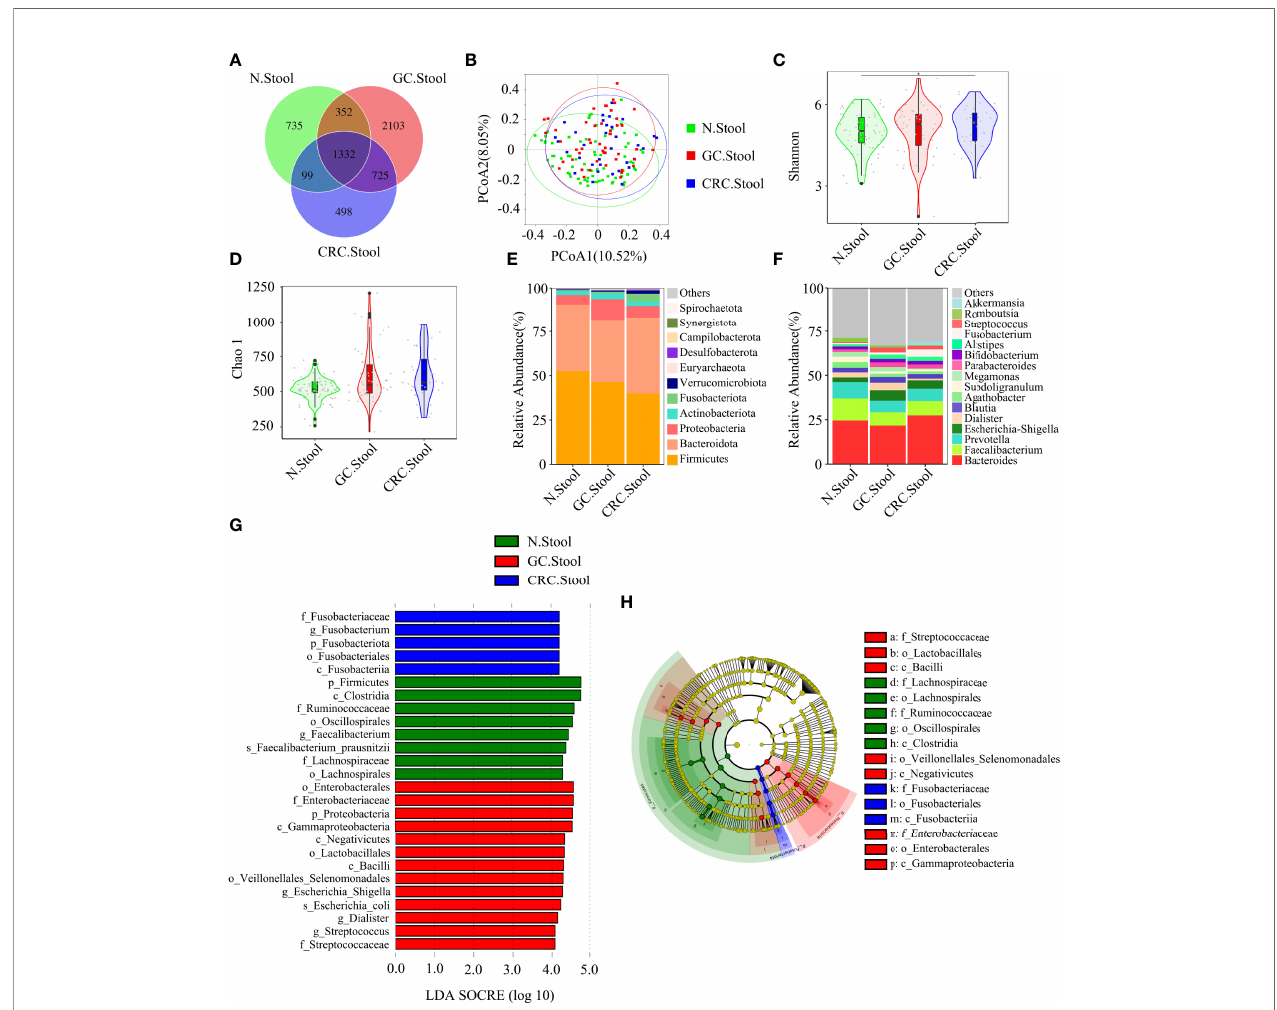
FIGURE 4 | There were differences in fecal microbial diversity among HC ( n = 70), GC ( n = 49), and CRC ( n = 33). (A) The Venn diagram displayed the overlaps among groups, showing a total of 5844 OTUs. (B) PCoA calculated b -diversity on a distance (dissimilarity) matrix of Bray – Curtis indexes. The Shannon index (C) and Chao1 index (D) were used to evaluate the fecal microbial diversity of patients with HC, GC, and CRC. Composition of fecal microbiota at the phylum level (E) and genus level (F) among the three groups. LDA and LEfSe methods were used to analyze the speci fi c characterization of the fecal microbiota of patients with HC, GC, and CRC. (G, H) The LEfSe method identi fi ed the most divergent taxa in GC and CRC and scored the two groups of fecal samples by LDA. Only the taxa that reach the effective threshold of LDA >4 were displayed. The brightness of each point was proportional to the size of its effect. * p <